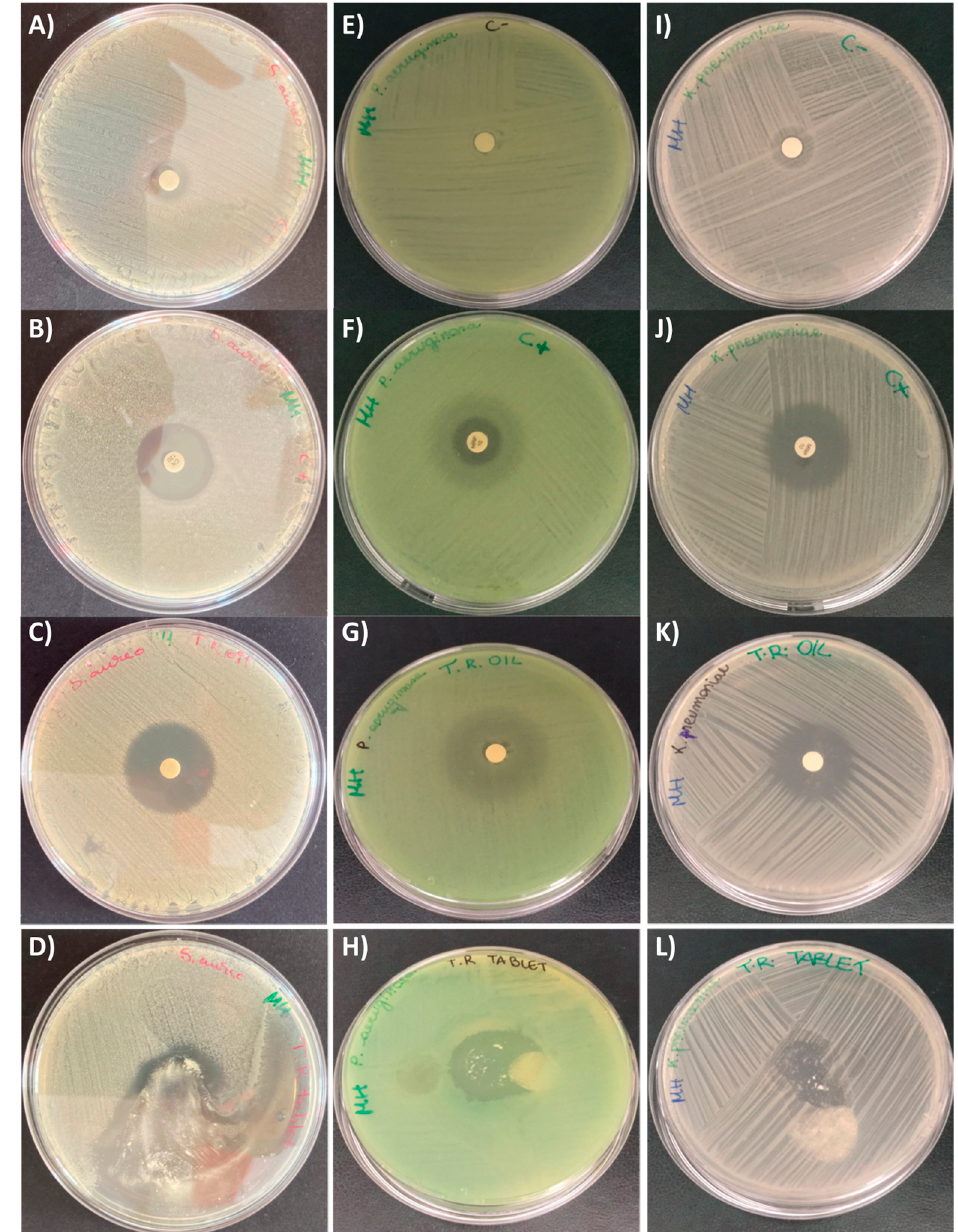
Figure 6. Growth inhibition halo (disk diffusion test) induced by T. vulgaris on S. aureus , P. aeruginosa, and K. pneumoniae . ( A ) S. aureus negative control (1,4-dioxane); ( B ) S. aureus positive control (gentamycin); ( C ) T. vulgaris essential oil against S. aureus ; ( D ) Tablet against S. aureus ; ( E ) P. aeruginosa negative control (1,4-dioxane); ( F ) P. aeruginosa positive control (meropenem); ( G ) T. vulgaris essential oil against P. aeruginosa ; ( H ) Tablet against P. aeruginosa; ( I ) K. pneumoniae negative control (1,4-dioxane); ( J ) K. pneumoniae positive control (meropenem); ( K ) T. vulgaris essential oil against K. pneumoniae ; ( L ) Tablet against K. pneumoniae .